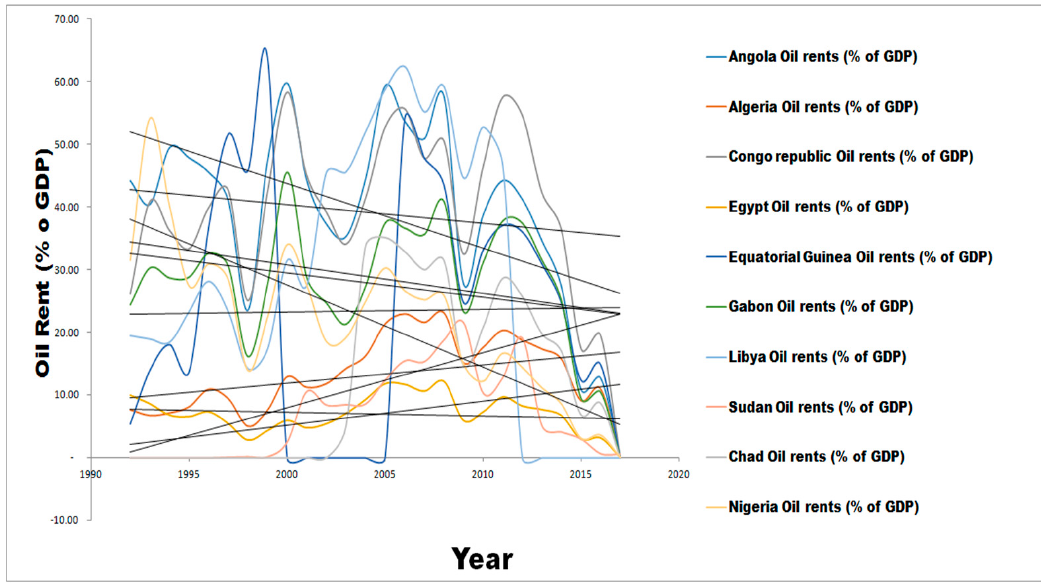
Figure 4. Oil rent in top ten crude oil-producing African countries - with trend lines. Source: World Bank data